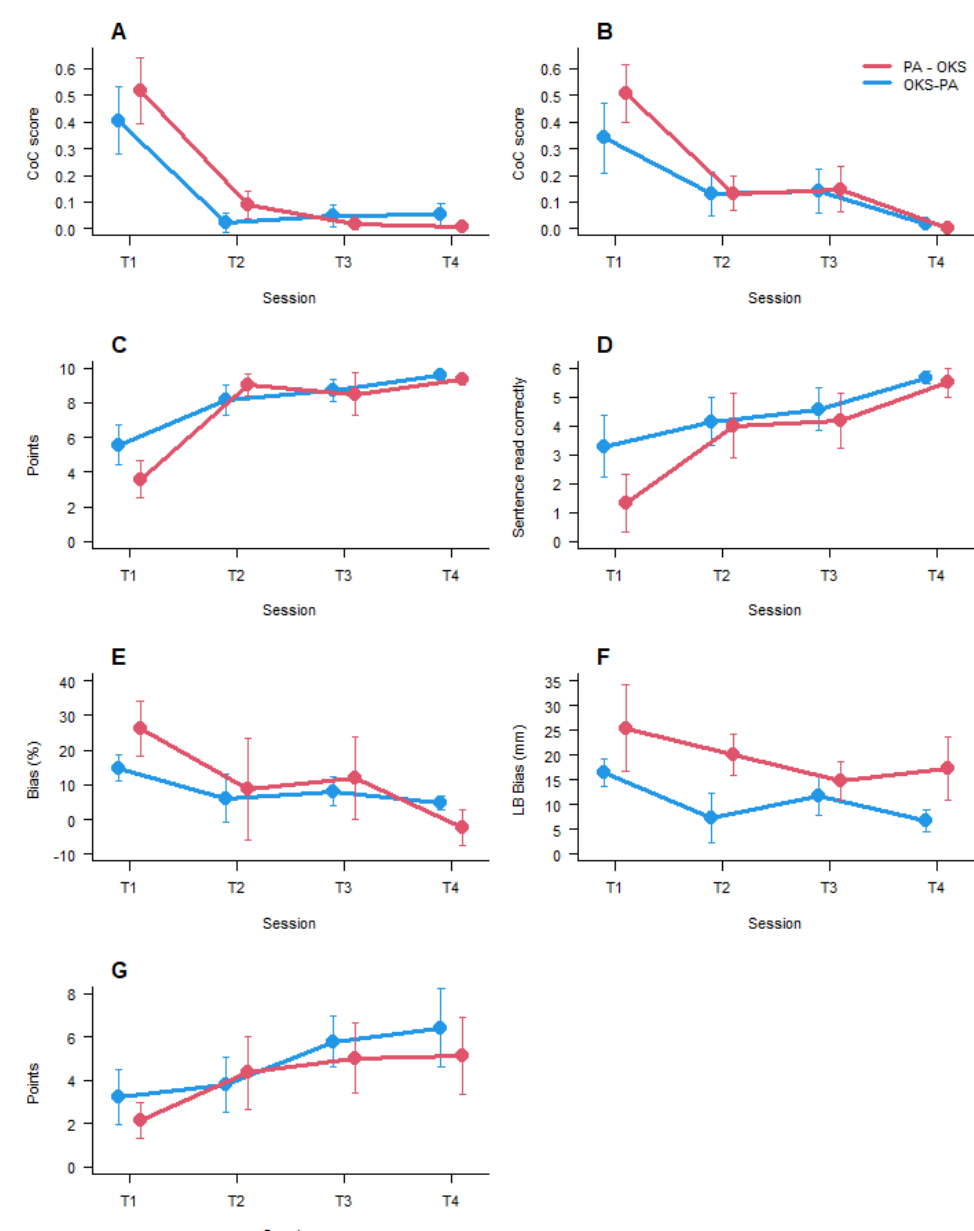
Figure 4. Mean results for each group relative to each specific session. ( A ) = Letter cancellation; ( B ) = Star cancellation; ( C ) = Figure copy; ( D ) = Sentence reading; ( E ) = Comb and razor; ( F ) = Line bisection; ( G ) = Clock Drawing. Bars represent ± 1 SEM. For letter cancellation, star cancellation, comb and razor, and line bisection score, the lower the better. For figure copy, sentence reading, and clock drawing, the higher the